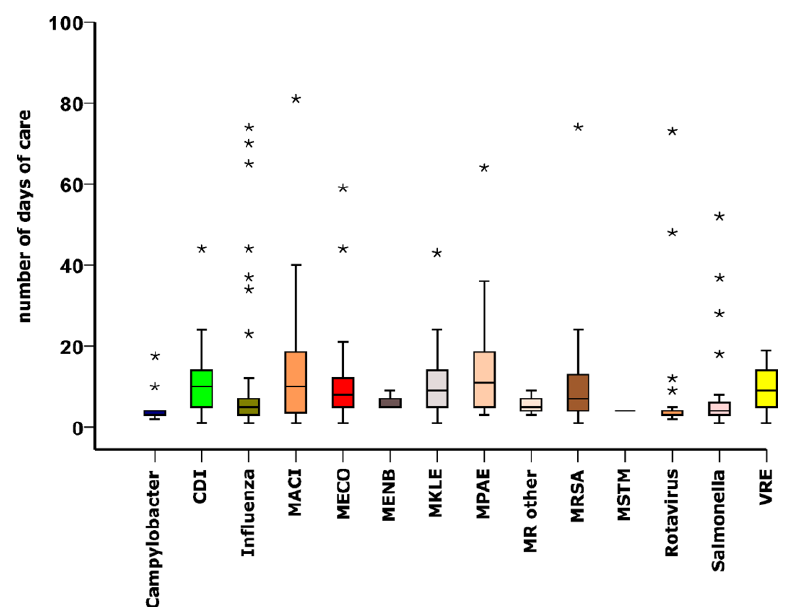
9 of 17 Figure 2. Distribution of length of hospital stay of patients with community-acquired gastroenteri- tis, influenza and multidrug-resistant infections detected at the University of Debrecen Clinical Cen- tre Nagyerdei Campus in 2020. Median, interquartile ranges and 1.5 times of interquartile ranges as whiskers are shown. Open circles and asterisks indicate outlier values. * p < 0.05, *** p < 0.001. Gas-